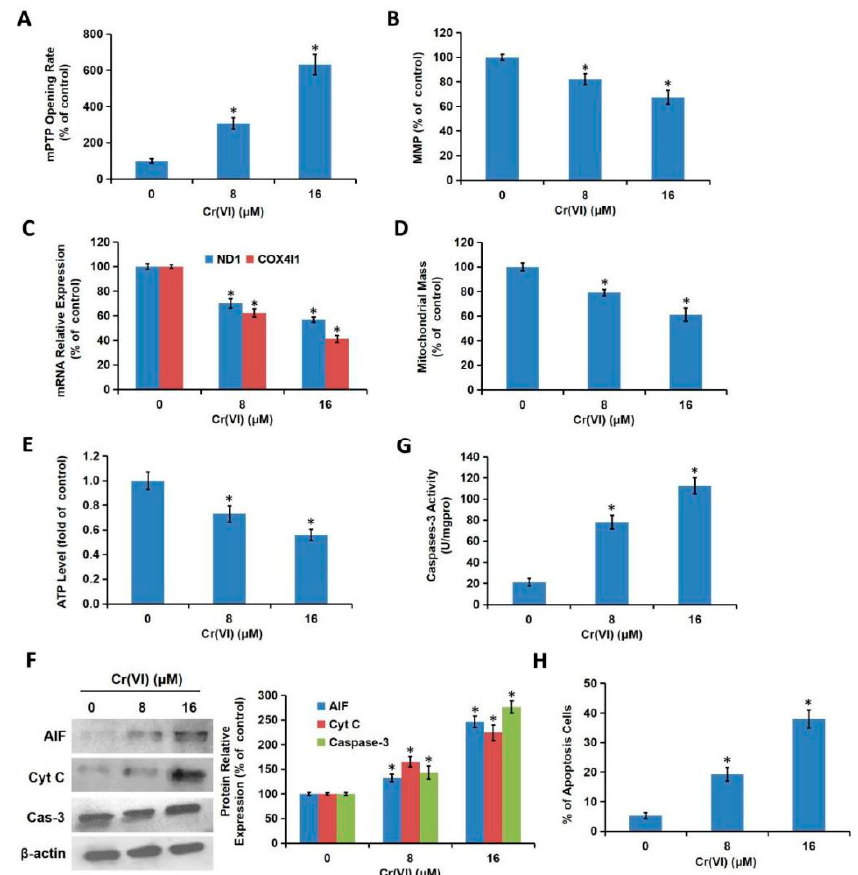
Figure 2. Cr(VI) induced mitochondrial-related cytotoxicity. L02 hepatocytes were treated with di ff erent concentrations of Cr(VI) (0, 8, 16 µ M) for 24 h. ( A ) The mPTP opening was examined different concentrations of Cr(VI) (0, 8, 16 µM) for 24 h. ( A ) The mPTP opening was examined using the commercial kit. ( B ) The MMP was detected using JC-1. ( C ) The mRNA levels of ND1 and COX4I1, which could reflect the copy number of mtDNA were detected using quantitative real-time polymerase chain reaction (qRT-PCR). ( D ) Mitochondria mass was examined using Mito-Tracker Green by flow cytometer. ( E ) The ATP level was examined using a luciferase-based luminescence enhanced ATP assay kit. ( F ) AIF, Cyt C, and caspase-3 protein expressions were detected using Western blotting analysis. The protein bands were quantitated using Image J software. ( G ) Caspase- 3 activity was determined using the commercial colorimetric assay kit. ( H ) The cell apoptosis was